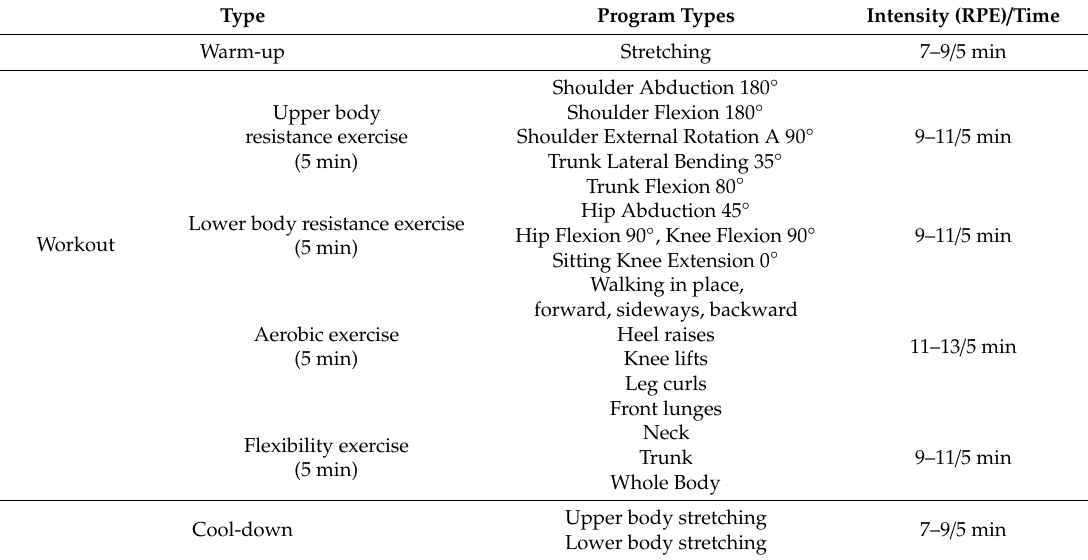
Table 2. Program design for augmented-reality-based exercise